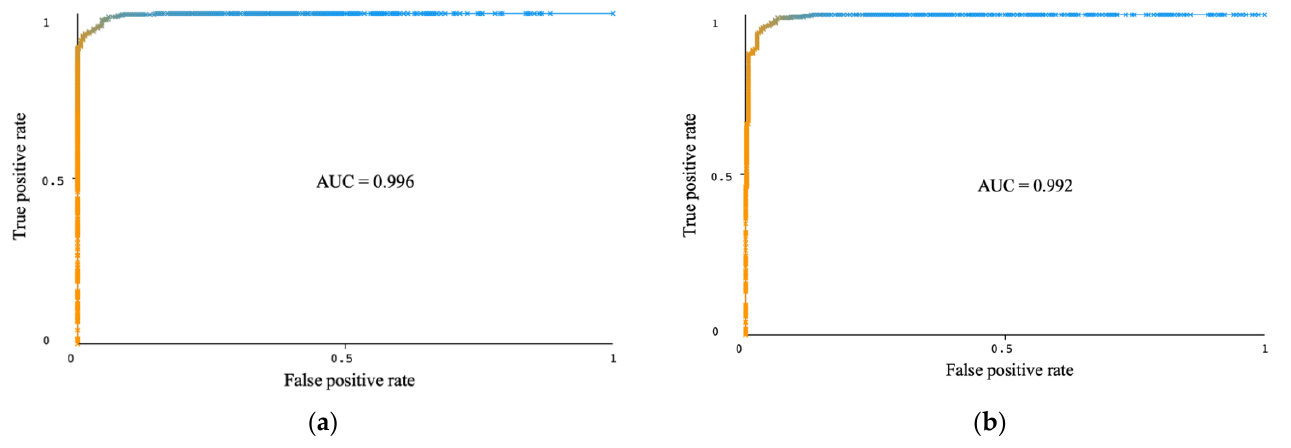
Figure 6. ROC plots of the Rotation Forest ensemble classifier with J48 as the base classifier. ( a ) Using a complete set of principal components; ( b ) using optimal set of principal components.